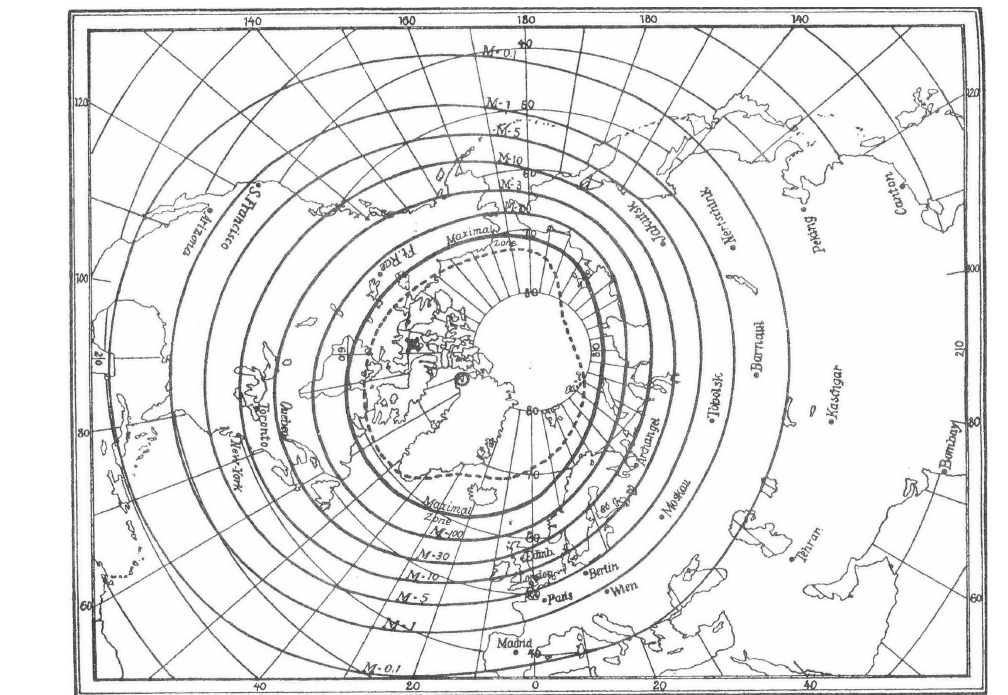
Figure 2. The distribution of isochasms in the Northern Hemisphere according to Fritz